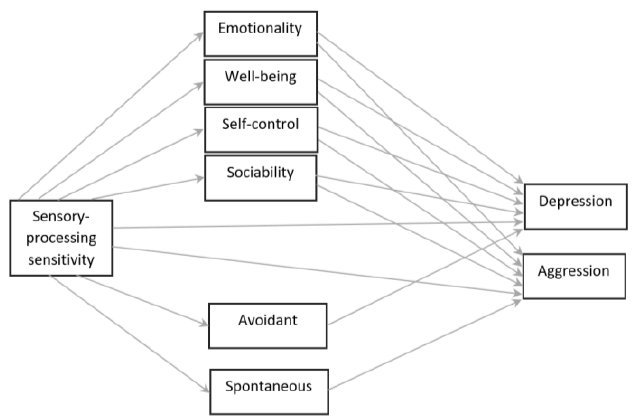
Figure 1. Theoretical model of sensory-processing sensitivity and pathways to depression and ag- gression: mediating roles of trait emotional intelligence and decision-making